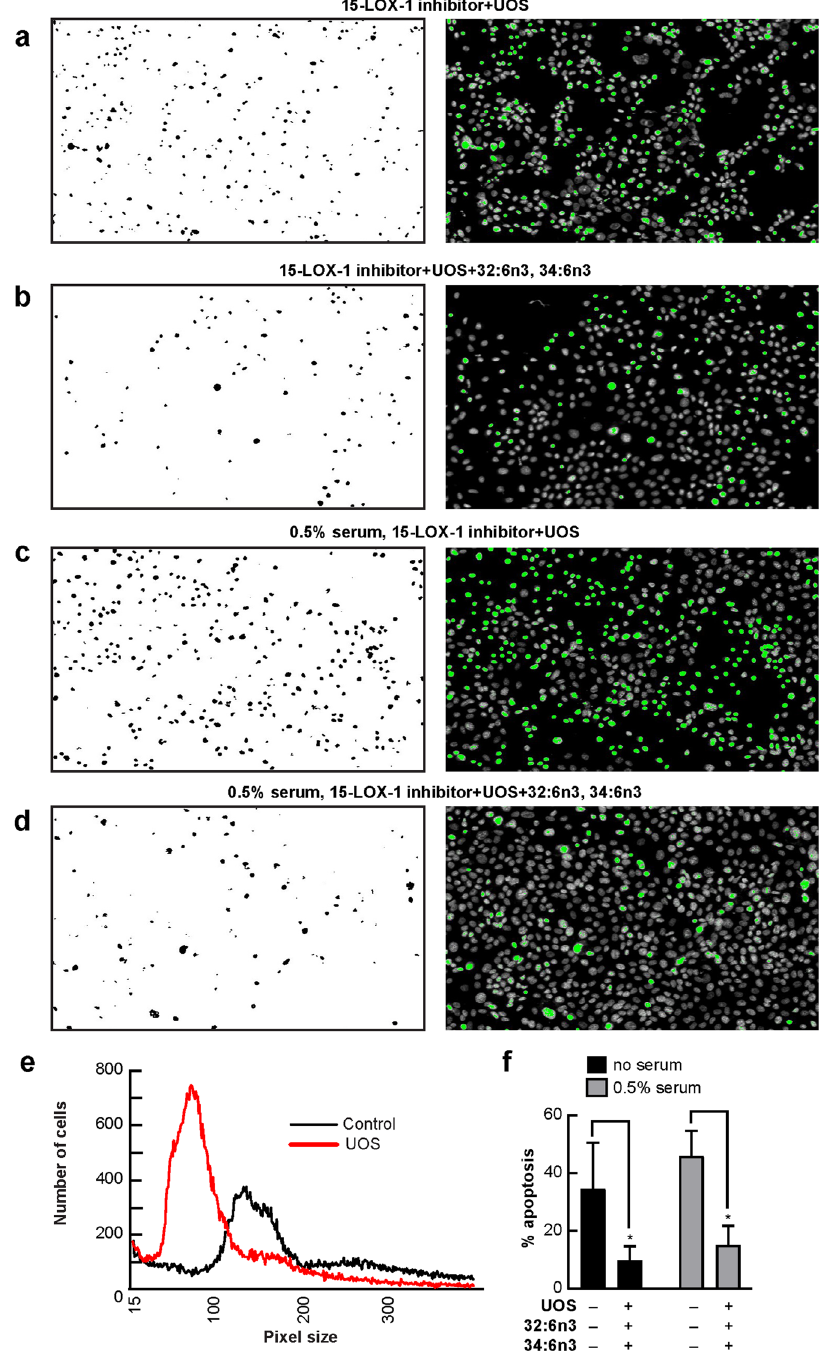
Figure 5. A 15-LOX-1 inhibitor does not modify cytoprotection against UOS mediated by 32:6n3 and 34:6n3 on primary human RPE cells. Serum-deprived ( a , b ) and low serum ( c , d ) primary human RPE cells were incubated with the 15-lipoxygenase-1 (15-LOX-1) inhibitor (10 micromolar, PD146176) for 1 hour, then subjected to oxidative stress (H 2 O 2 /TNF α ) for 16 hours to induce apoptosis ( a – d,f ). The addition of 32:6n3 and 34:6n3 protected human RPE cells ( b , d , f ) from cell death. Typical fields of cell cultures are represented in the right column. Nuclei are labeled with Hoechst staining, and the dead cells are highlighted in green. These were separated using an intensity threshold algorithm and counted using an Image J macro (left column) 70 . ( e ) Quantification of live (control cells; black curve) and dead (UOS cells, red curve) cells was based on nuclear size 70 . Error bars, SEM; * p <